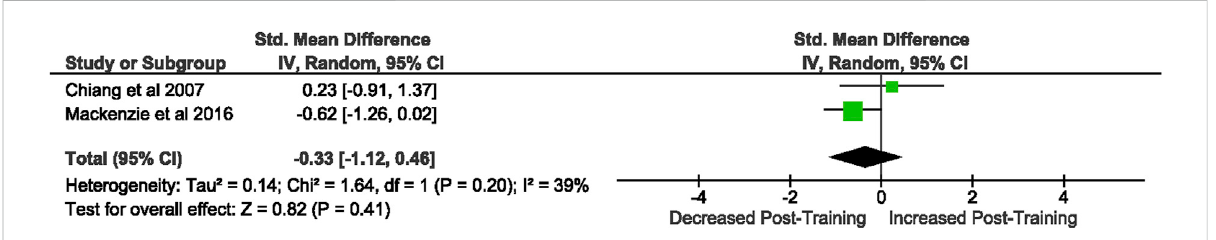
FIGURE 10 Effect of intensi fi ed training on resting dendritic cell CD80 expression. All studies used rodent participants. CI Con fi dence interval.